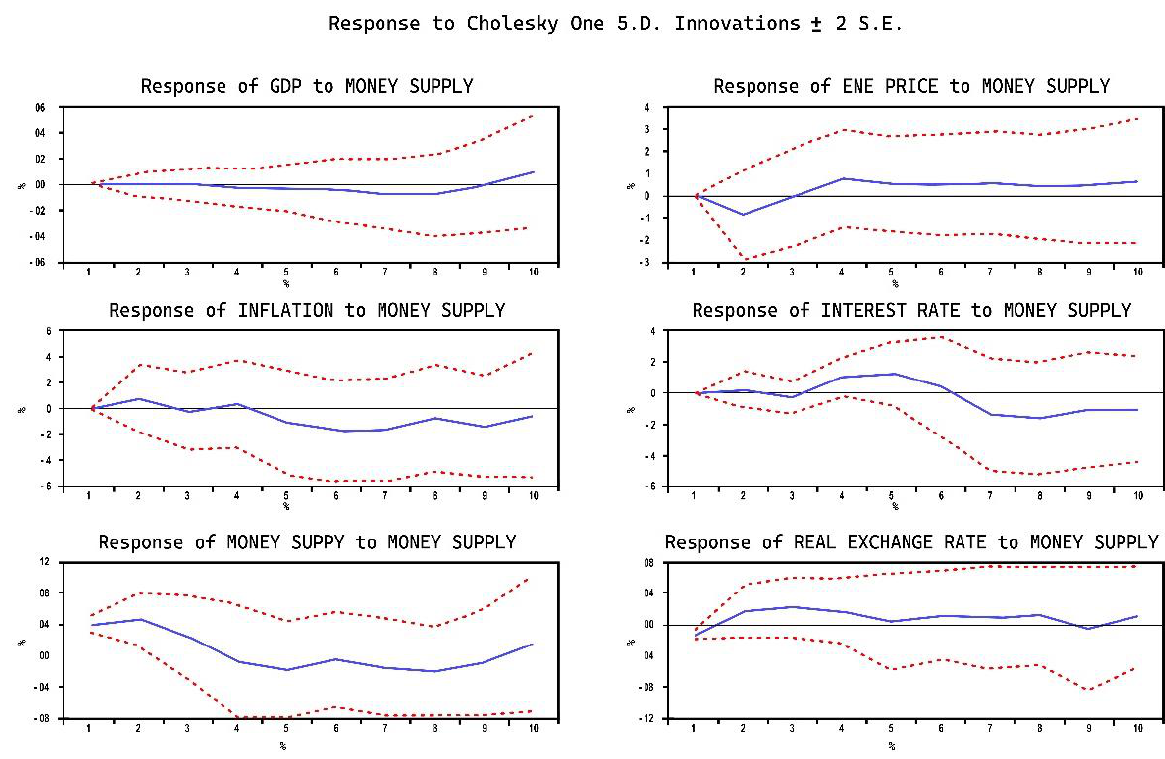
Figure 5. IRF to money supply (VAR IRF with intercept using annual data for 1980 – 2022).